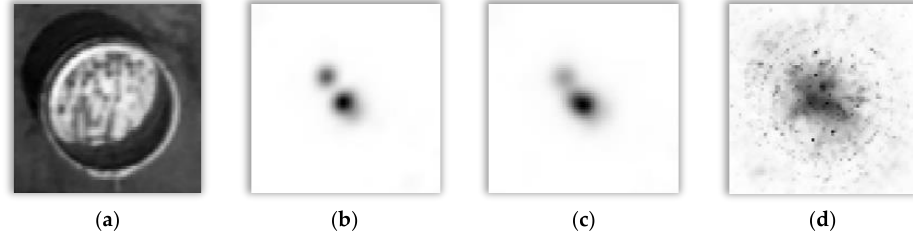
Figure 10. Comparison of results. ( a ) Original image; ( b ) when the radius is 23.5; ( c ) when the radius range is [20,27]; ( d ) when the radius range is [1,34]. Comparing Figure 10b,c with Figure 7b,c, it can be found that FGMRST can better extract and distinguish the two circle centers. However, the final symmetry map is pro- duced after combining all radial symmetry images [27]. Thus, different radii information is accumulated in the output of the transform [27]. As long as the value of input radius is